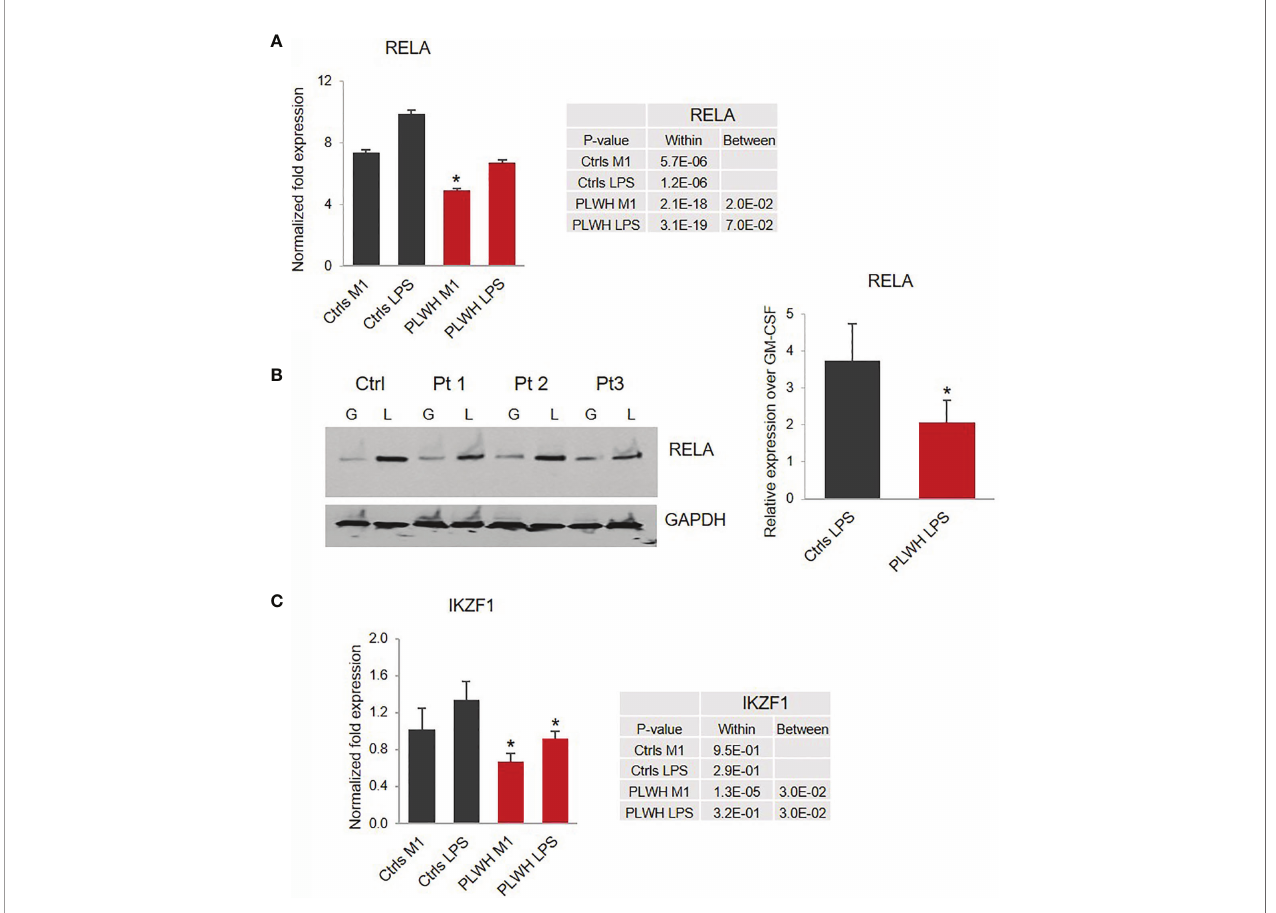
FIGURE 4 | Impaired expression of RELA and IKZF1 in PLWH-MDMs compared to controls. (A) Relative expression of RELA mRNA calculated over T0. Error bars indicate SEM; *indicates statistical signi fi cance between groups (Ctrls, n=10; PLWH, n=25). (B) Expression of RELA protein in MDMs obtained from Ctrls (n=4) and PLWH (n=9) treated with GM-CSF (G) and LPS (L). Blots were quanti fi ed using image J software. The graph represents the ratio of RELA in LPS compared to GM- CSF after normalization with GAPDH (right panel). *Indicates statistical signi fi cance between Ctrls and PLWH. (C) Relative expression of IKZF1 in controls (n=10) and PLWH (n=25). The tables report speci fi c P -values calculated within each group and between